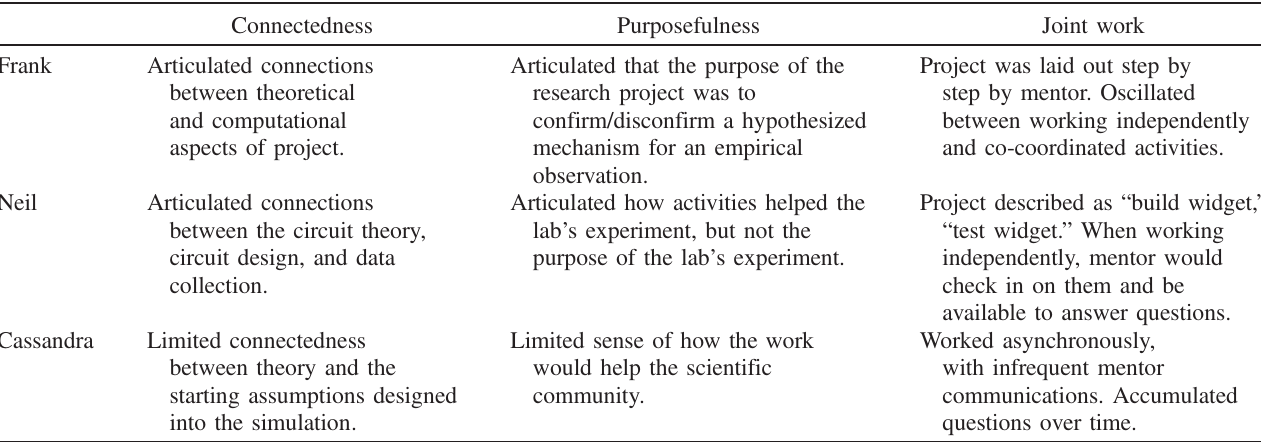
TABLE II. Summary of connectedness, purposefulness, and joint work across the three case